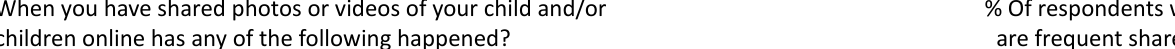
Table 6. Sharenting practices by type of parent and child communication about sharenting. When you have shared photos or videos of your child and/or % Of respondents who children online has any of the following